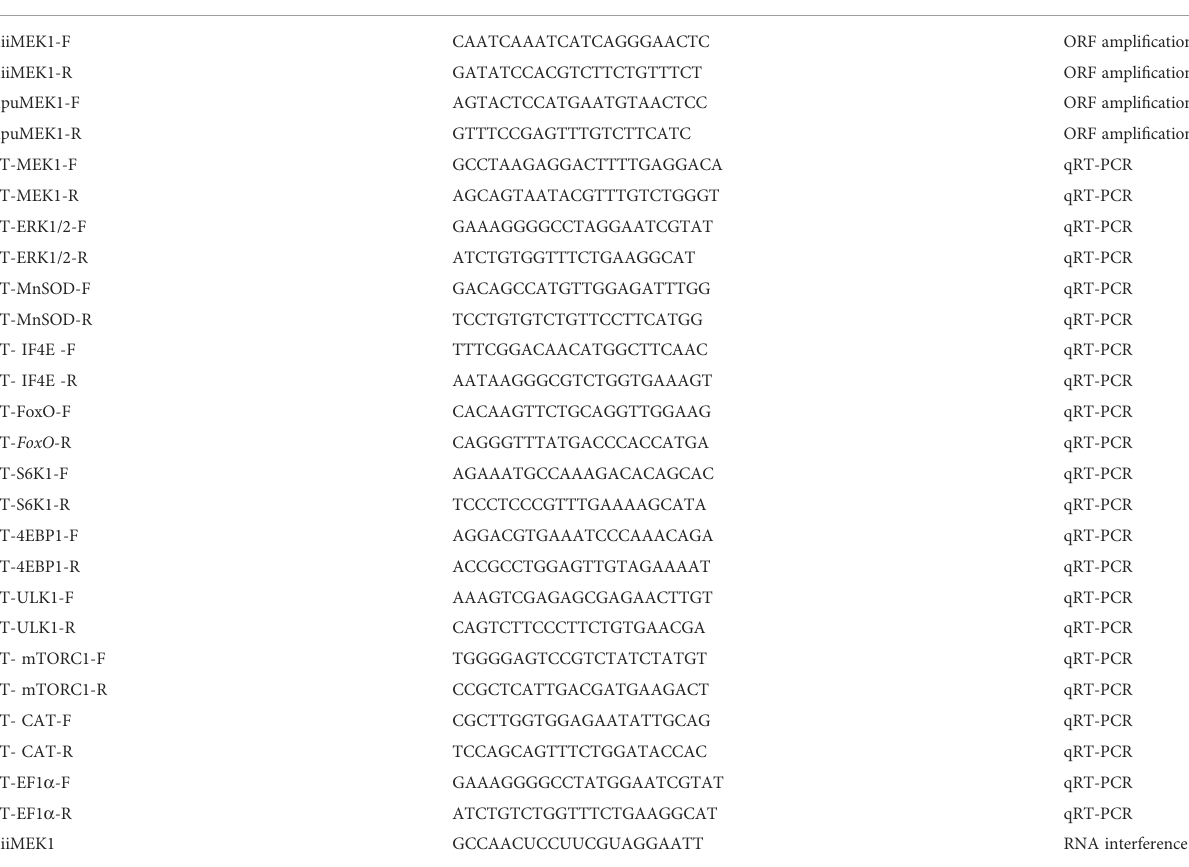
TABLE 1 Primers used in this